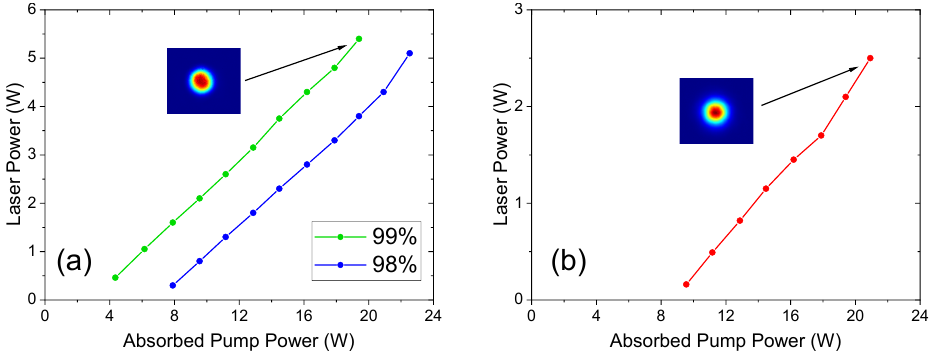
Figure 4. Laser power as a function of absorbed pump power for plane–plane cavity ( a ) with HR mirror ( b ) with VBG.